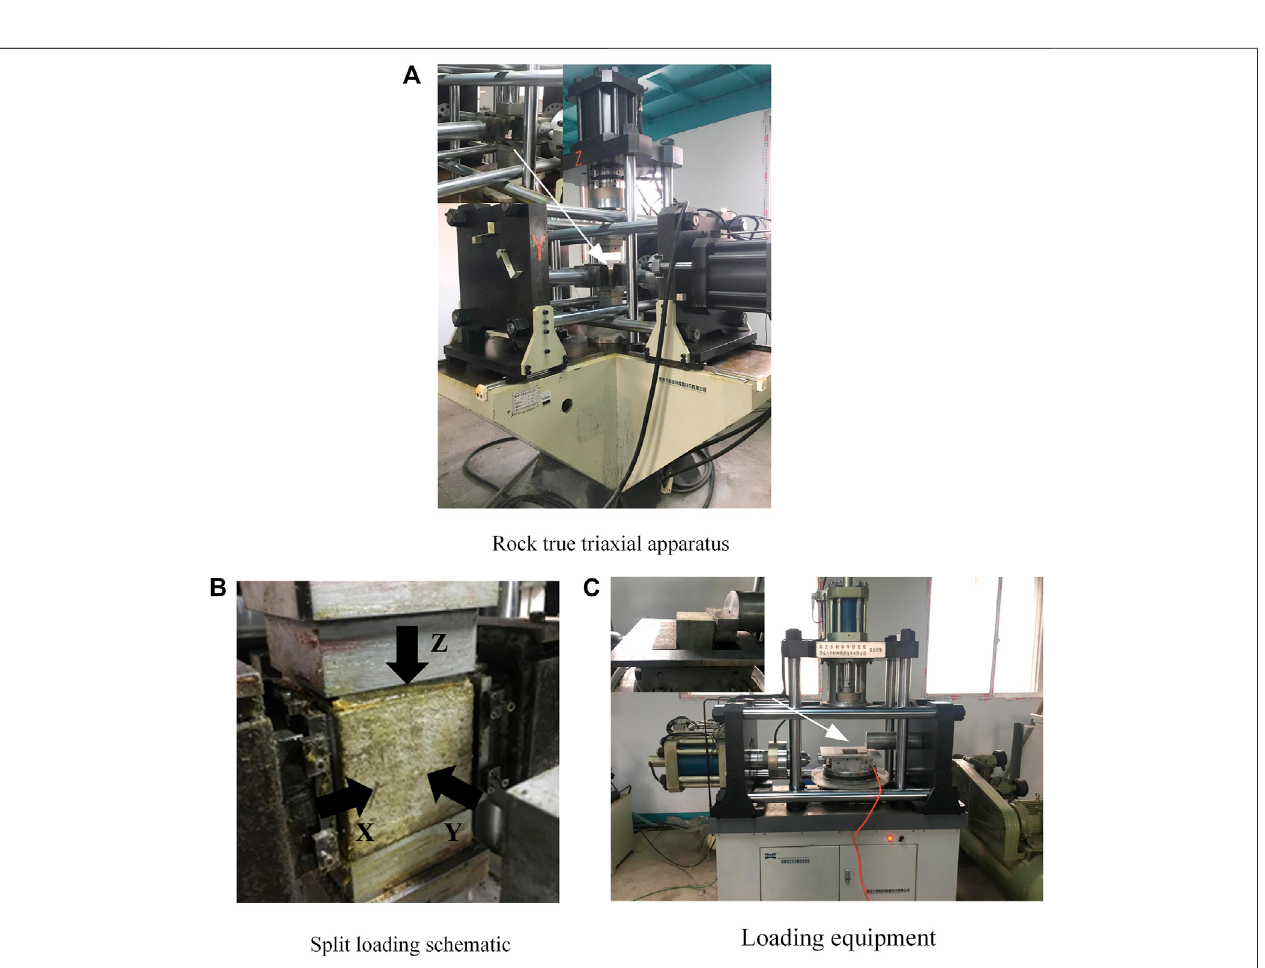
FIGURE 2 | Experiment equipment and loading method. (A) Rock true triaxial apparatus. (B) Split loading schematic. (C) Loading